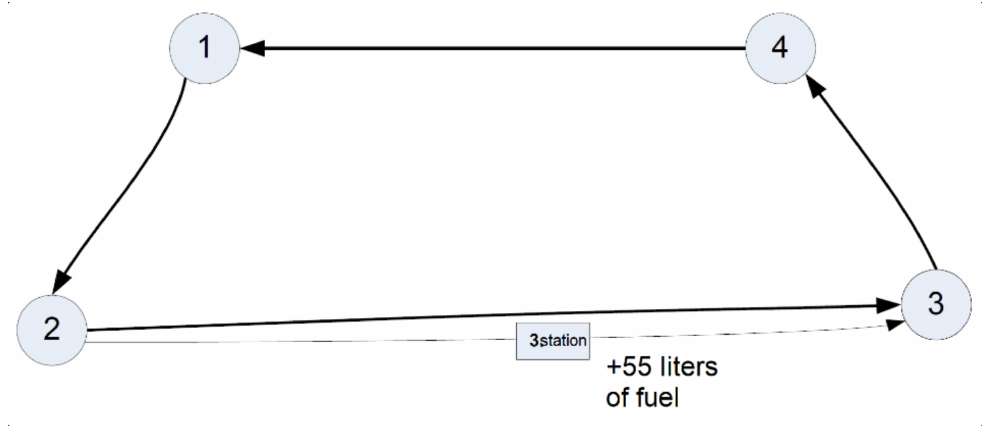
Figure 7. The optimal route with one